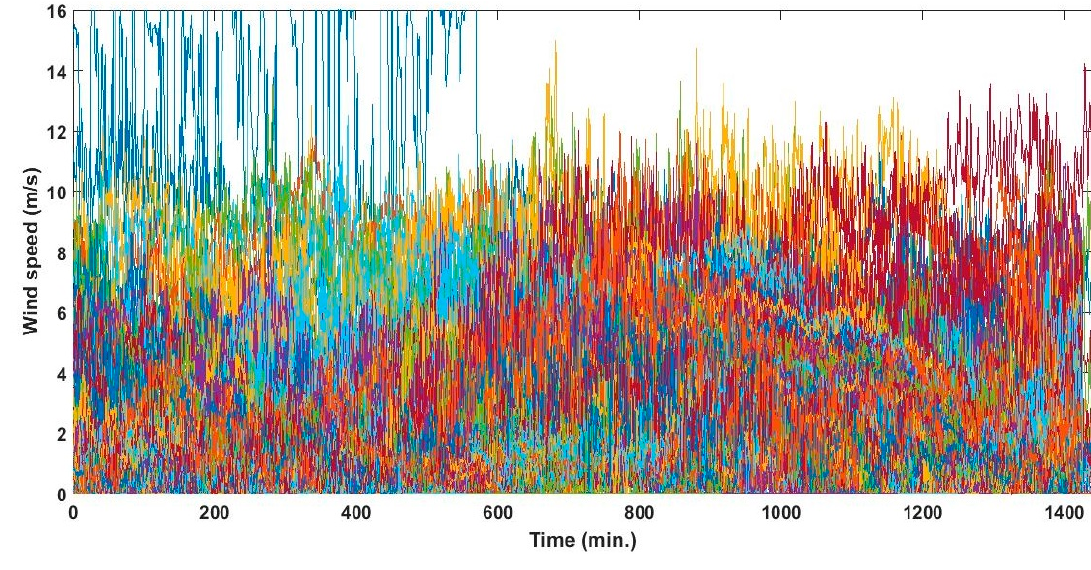
Figure 9. Initial data set.